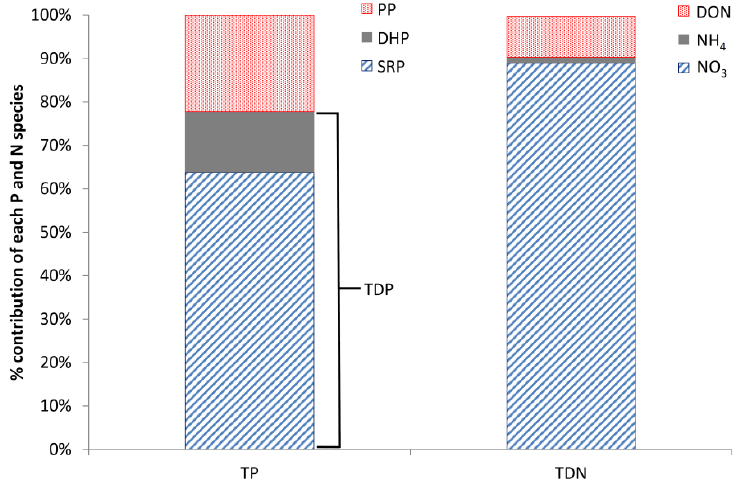
Figure 6. ( a ) Soluble reactive P (SRP) and total reactive P (TRP) concentrations in weekly grab samples (on different days) in the Enborne at Brimpton. The mean annual